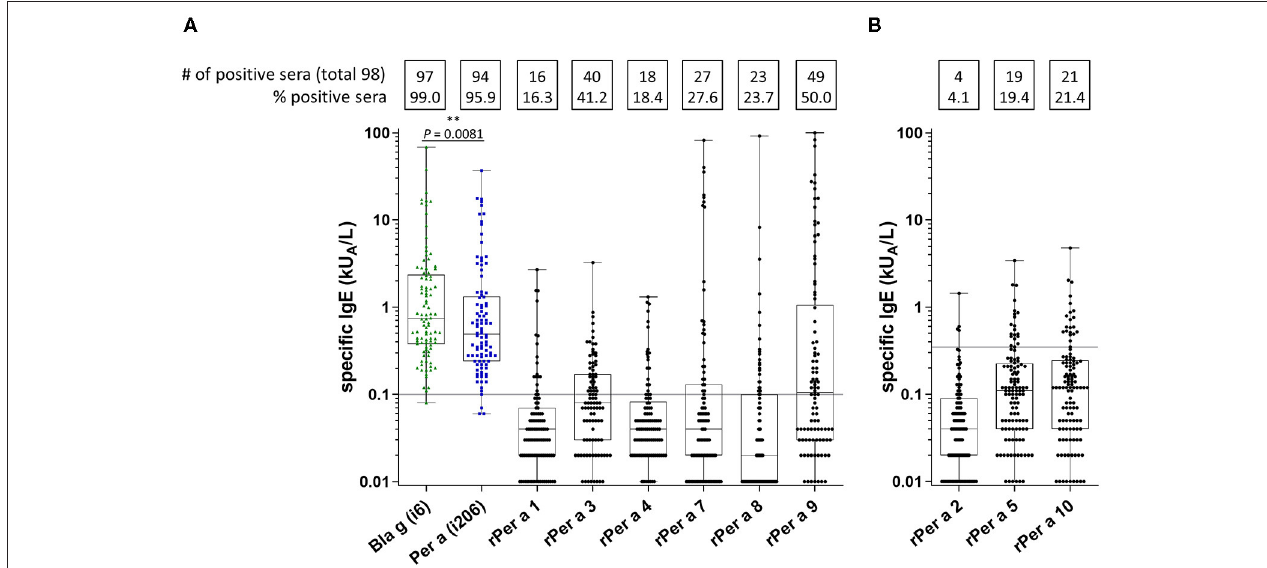
FIGURE 3 | CRD of cockroach allergy by experimental ImmunoCAP testing including cockroach-allergic patients preselected by positive Periplaneta- or Blattella -specific ImmunoCAP values ( n = 98). Specific IgE values for Periplaneta and Blattella extracts and Per a 1, Per a 3, Per a 4, Per a 7, Per a 8, and Per a 9 (cutoff 0.1 kU A /L) (A) , as well as for Per a 2, Per a 5, and Per a 10 (cutoff 0.35 kU A /L) (B) are depicted. (paired t -test).